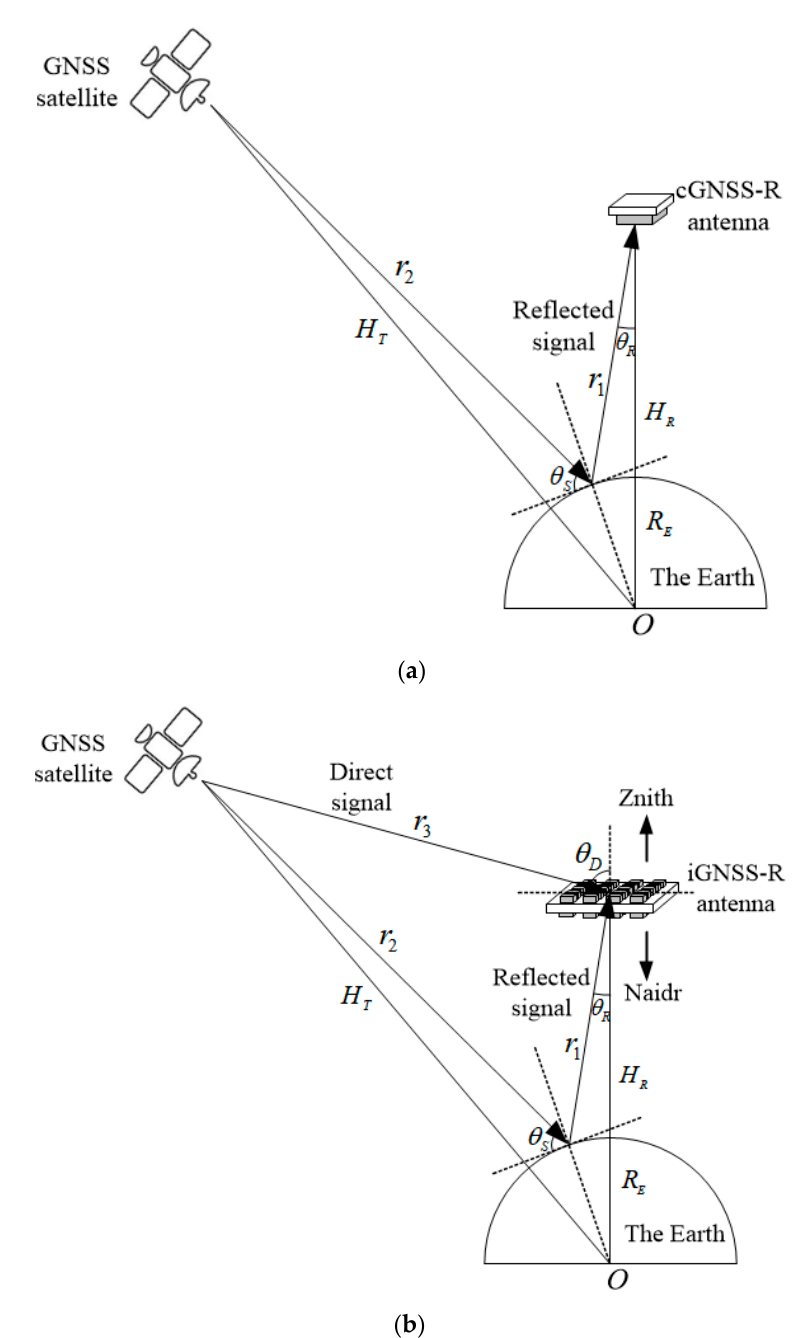
Figure 1. The basic structure and geometric relationship of the ( a ) cGNSS-R system and ( b ) iGNSS-R system, where O indicates the Earth’s core, θ S indicates the elevation angle, R E indicates the Earth radius, H T and H R indicates the orbital height of the transmit and receive antenna, respectively, r 1 indicates the distance between the specular point and the GNSS-R antenna, r 2 indicates the distance between the GNSS satellite and the specular point, and r 3 indicates the distance between the GNSS satellite and the GNSS-R antenna.